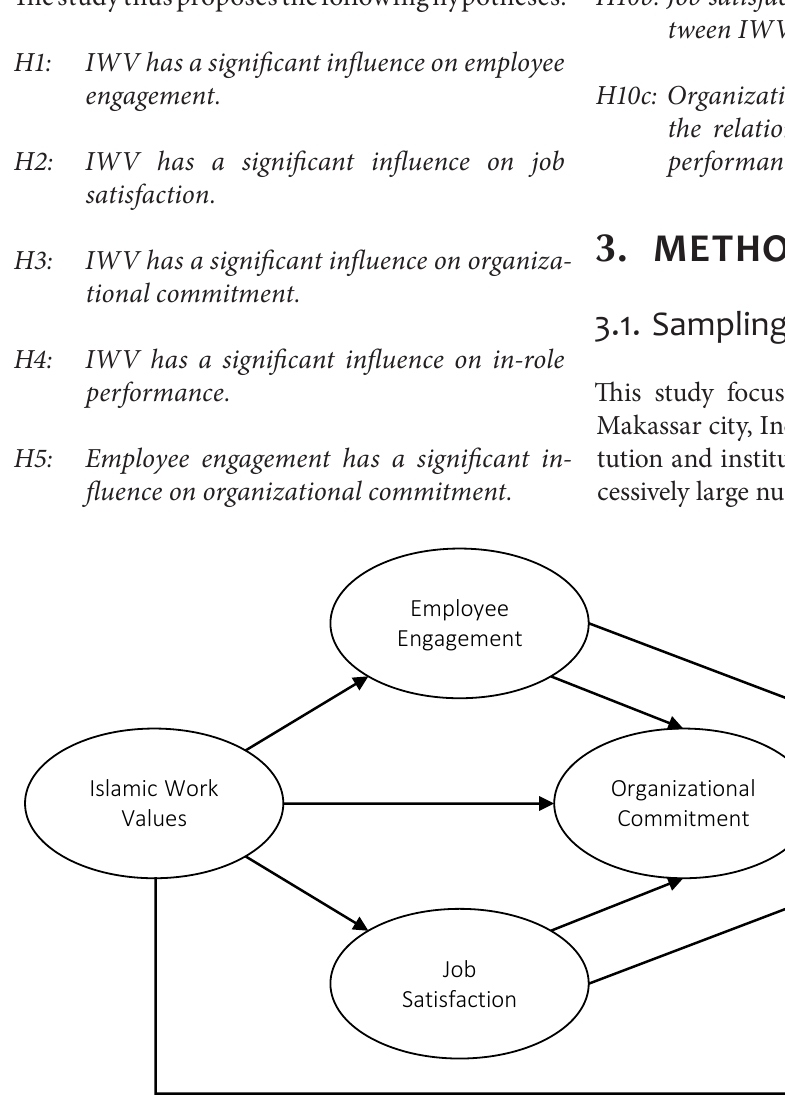
Figure 1. Conceptual framework